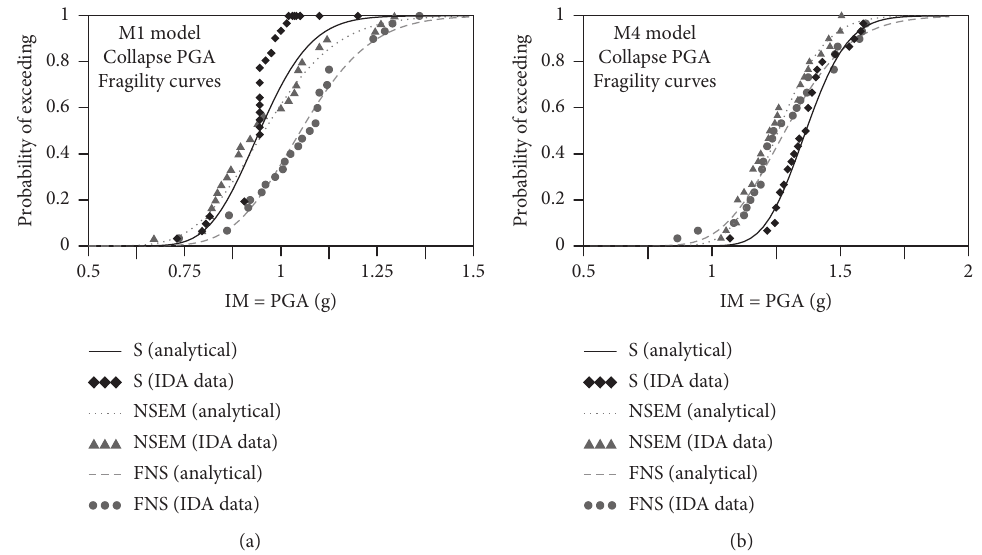
Figure 12: Fragility curves: model M1 (a) and model M4 (b): probability of collapse damage exceeding with different